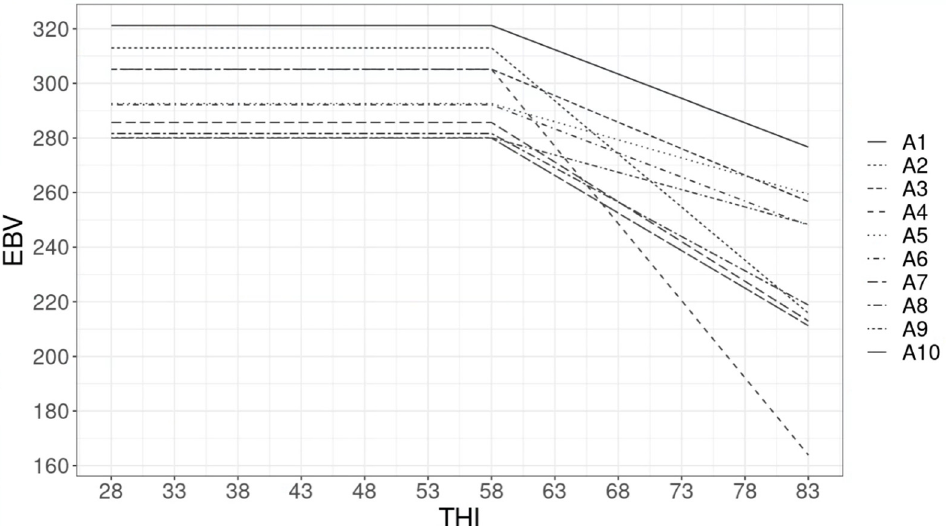
Figure 4. Top 10 bulls’ estimated breeding value (EBV) for protein yield as a function of the temperature-humidity index (THI).